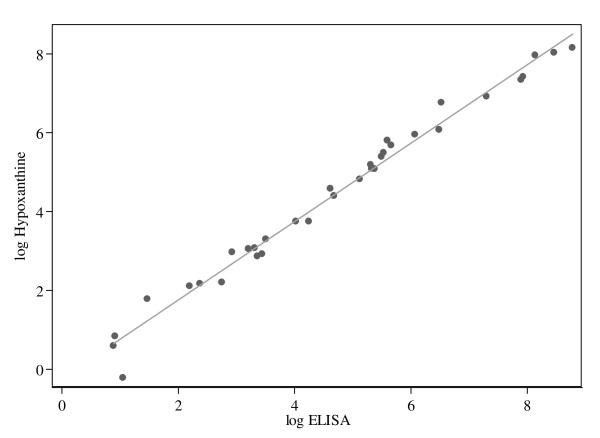
Correlation of log IC50s obtained from the aldolase ELISA and the [3H]hypoxanthine method with the P. falciparum strain NF54. 34 compounds were tested by ELISA and [3H]hypoxanthine incorporation (n = 1) with the P. falciparum strain NF54. The log IC50 in nM (or ng/ml for the standard compounds) from [3H]hypoxanthine incorporation is plotted against the log IC50 from ELISA, for each compound. (n = 34, correlation coefficient (R) = 0.991 and p-value < 0.001).